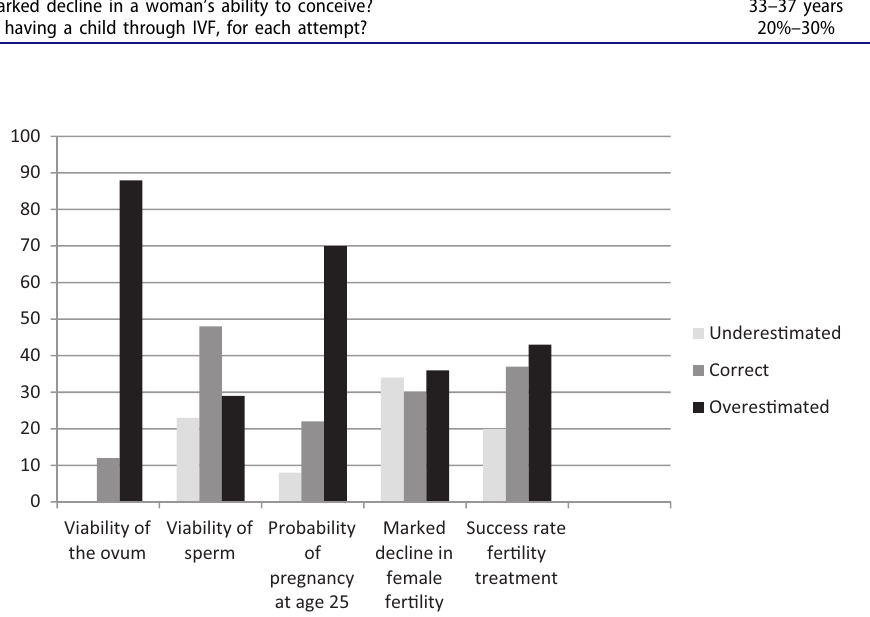
Figure 2. Percentages of underestimated, correct, and overestimated